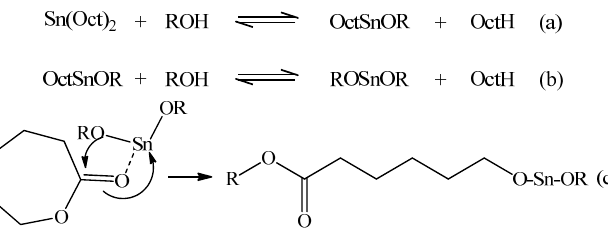
Figure 1. Mechanism of initiation of ROP using Sn(Oct) 2 as the precatalyst and a mono-functional alcohol initiator.